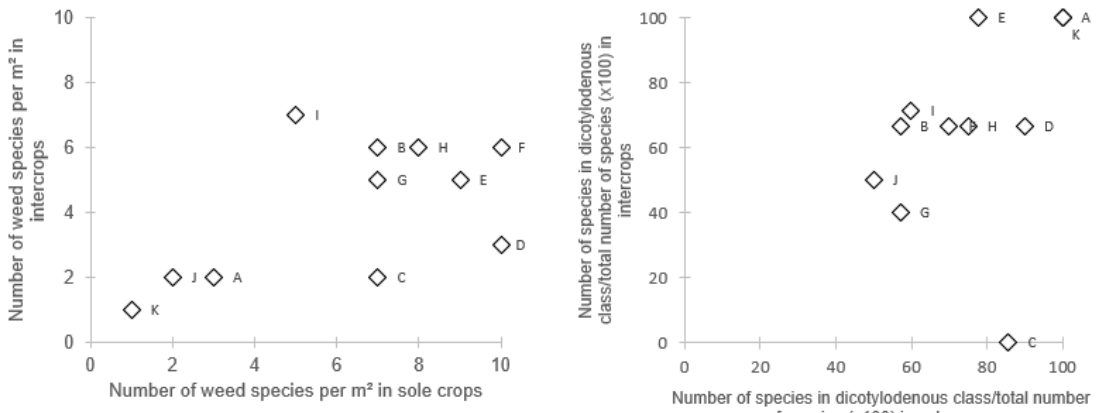
Figure 7. ( a ) Number of weed species in intercrops against number of weed species in lupin sole crops. ( b ) The percentage of dicotyledonous species in the total number of weed species in intercrops against the percentage in lupin sole crop. The dashed lines represent the theoretical situations with equal values in both cropping strategies.